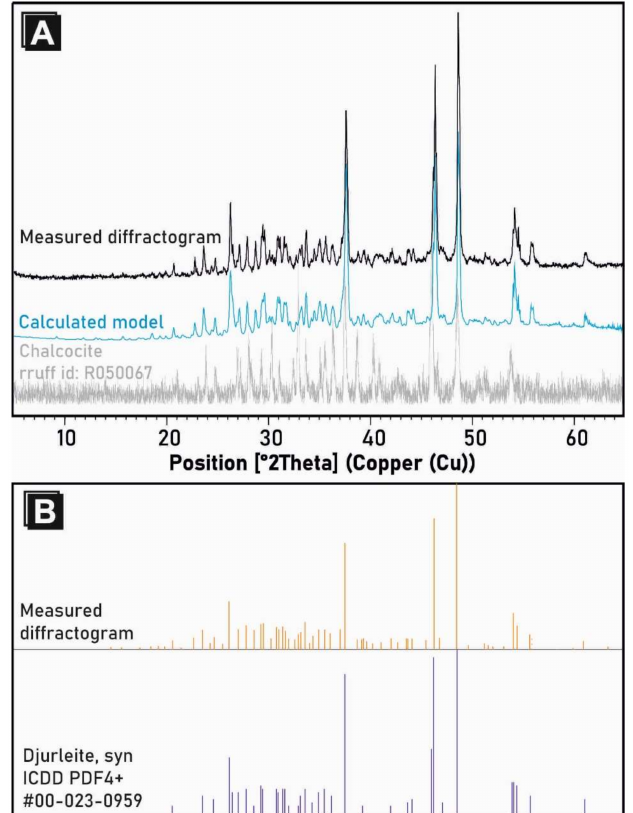
Figure 3. ( A ) XRD pattern of the investigated djurleite compared with both calculated models (by the Rietveld method) and chalcocite (a basic standard). ( B ) List of all peaks from the characterized sample and a typical djurleite (ICDD, PDF4+ standard, #04-007-1283 reference